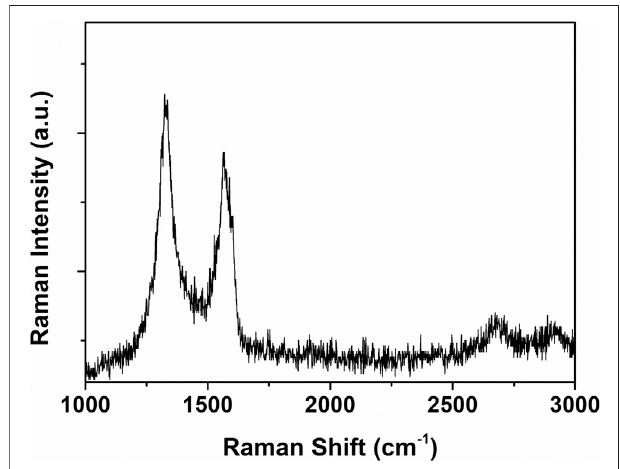
FIGURE 6 | Raman spectrum of the graphene sheets prepared with pH buffer at an initial pH value of 11.